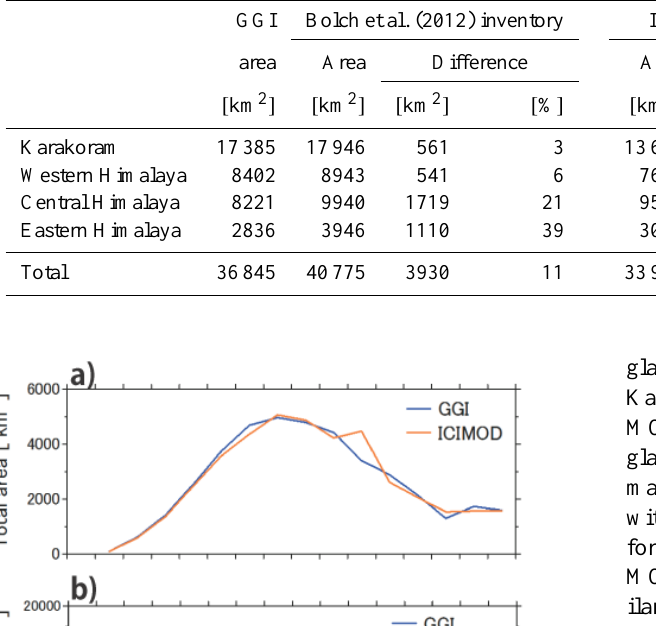
Table 3. Comparison of regionally aggregated total glacier areas from the GGI, Bolch et al. (2012) inventory, ICIMOD inventory, and the RGI. The uncertainty in the RGI ver. 4.0 was calculated using the error estimation equation (Eq. 1) in Pfeffer et al. (2014).